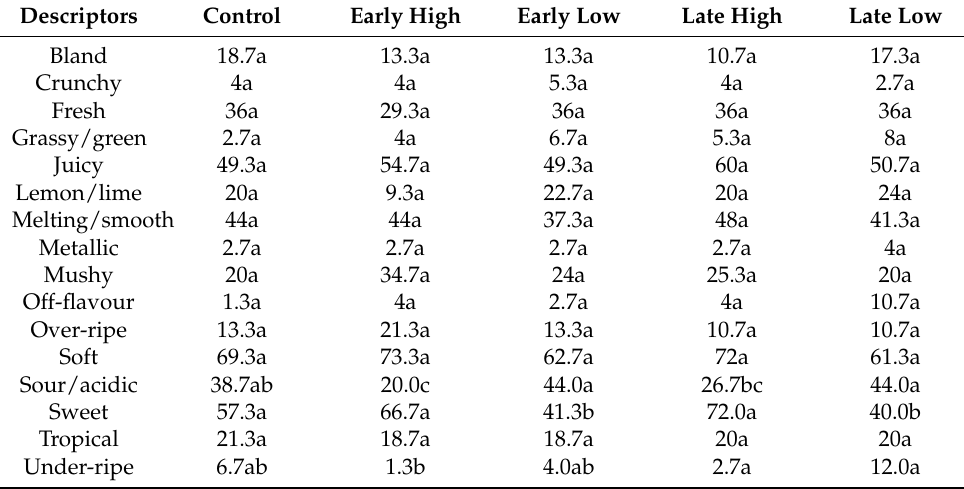
Table 1. Citation frequencies (% of consumers) for terms used to describe the sensory attributes for Actinidia chinensis var. chinensis ‘Zesy002’, kiwifruit from five treatments receiving varying carbohydrate supplies. n = 75 consumers. Statistical significance ( p < 0.05) is shown for descriptors using different letters following citation